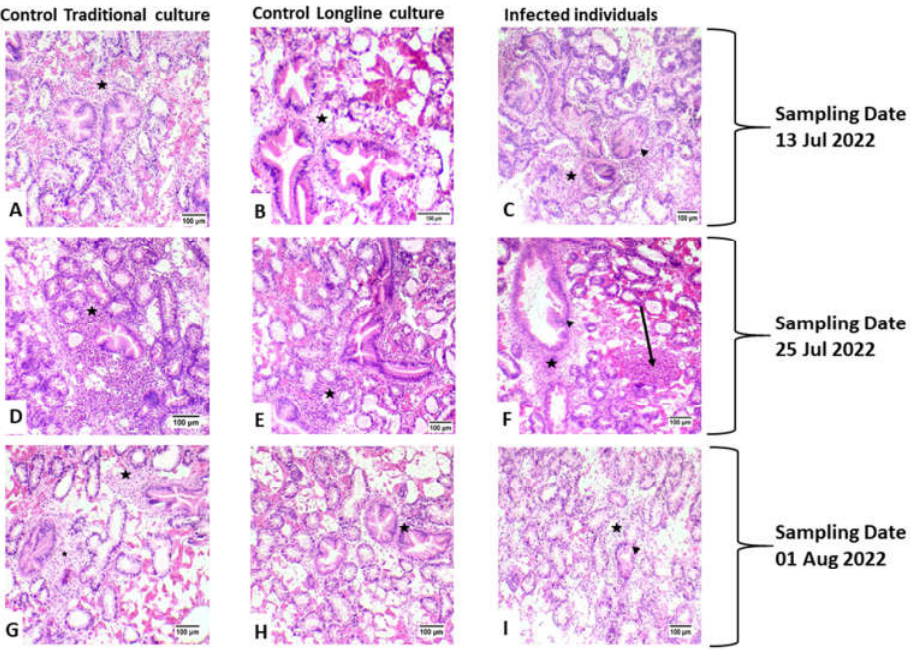
Figure 3. Histological display of sampled M. galloprovincialis individuals. ( A – C ) represent samples from the first sampling (13 July 2022), ( D – F ) represent samples from the second sampling (25 July 2022) and ( G – I ) are from the third sampling (1 August 2022). Regardless of the culture type or the health condition of the samples, all samples presented heavy hemocyte infiltration (star), while in samples infected with Marteilia refringens nodular type exhibited inflammation (arrow) and epithelial tissue degeneration (arrowhead) [H&E staining (×20 Objective)].